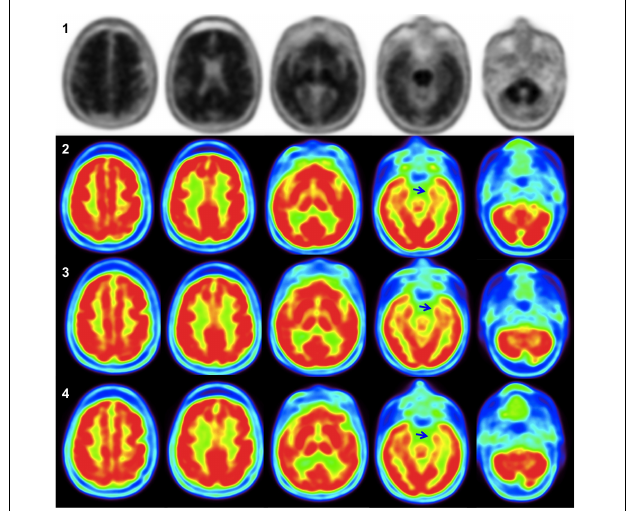
FIGURE 2 | In amyloid PET images (1) , the uptake of the grey matter equals that of the white matter in the lateral temporal, parietal, posterior cingulum/precuneus, and especially in the frontal lobe, thus being considered a positive study for amyloid deposition. 18F-FDG-PET images at diagnosis (2) show only mild mesial hypometabolism, predominantly in the left hemisphere (blue arrow). 18F-FDG-PET studies showed no evolution of hypometabolism at 1 year (3) , and 2 years after diagnosis (4) (blue